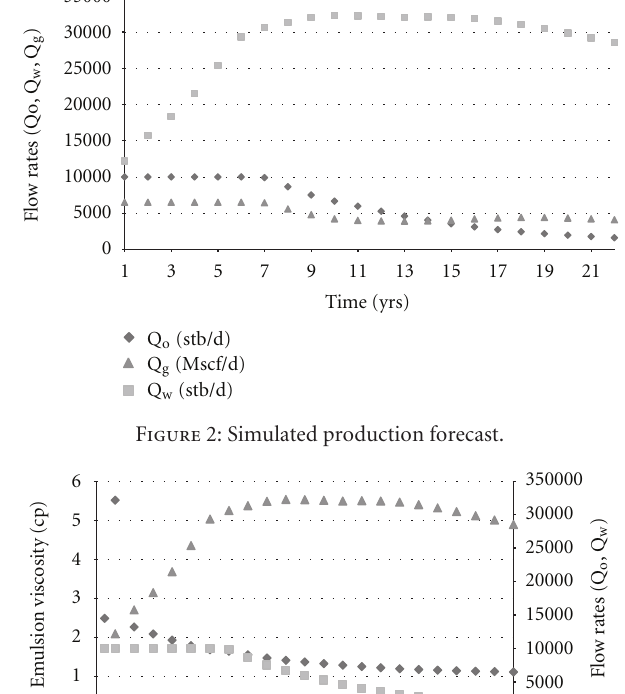
Table 1: Emulsion type resulting from phase dispersion coe ffi cient.